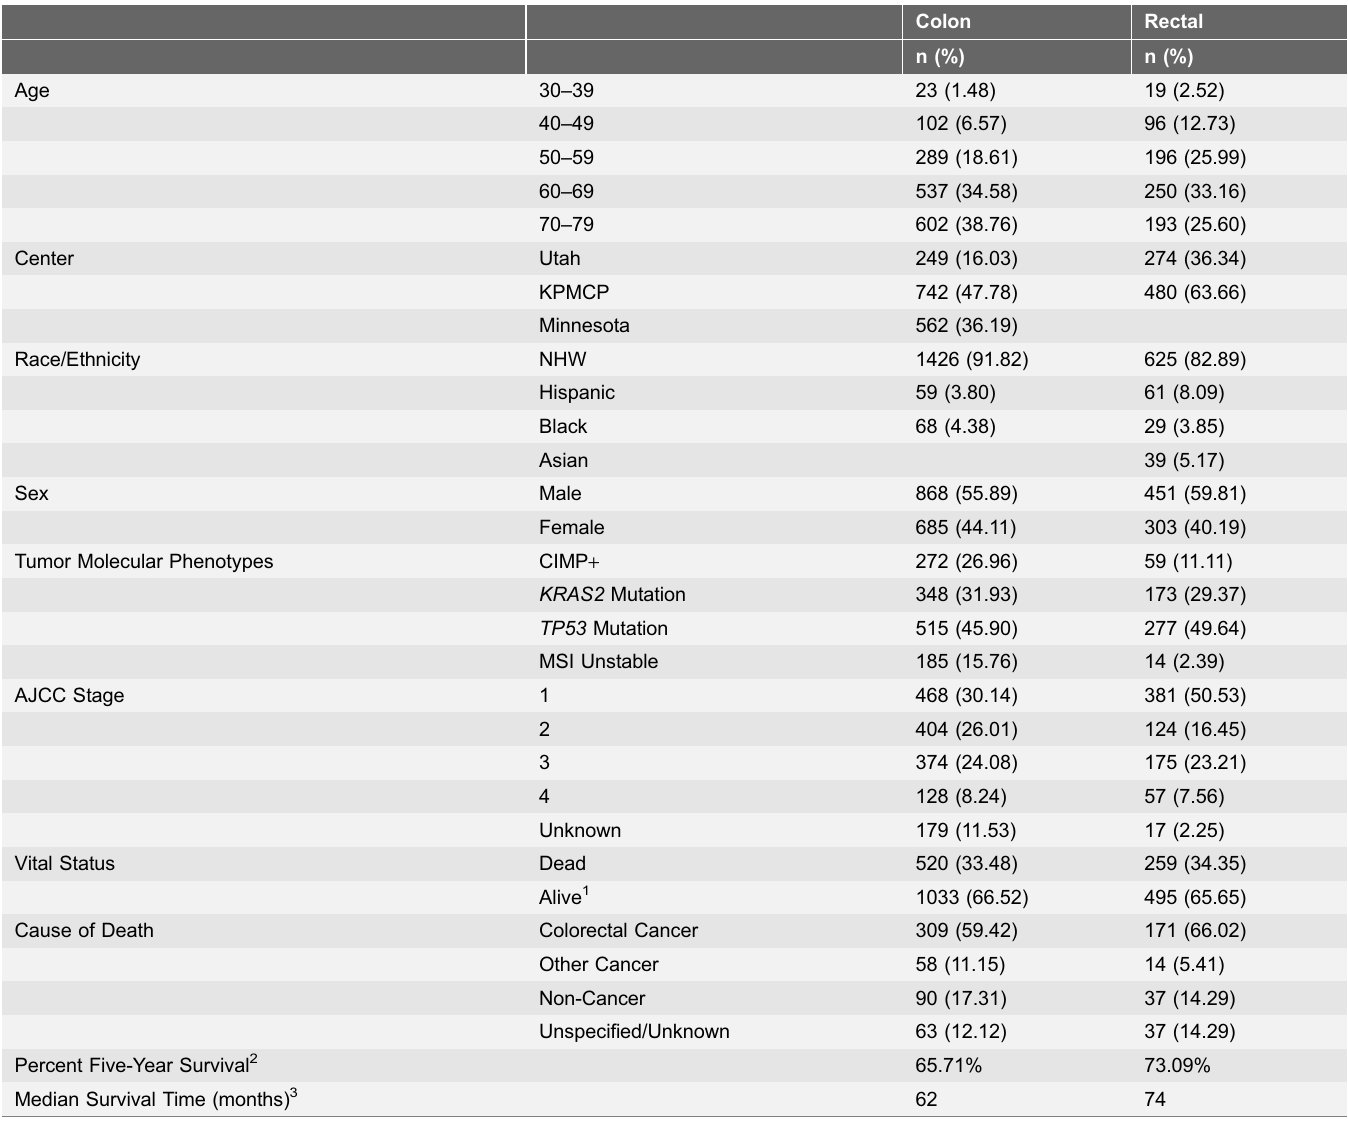
Table 1. Description of study